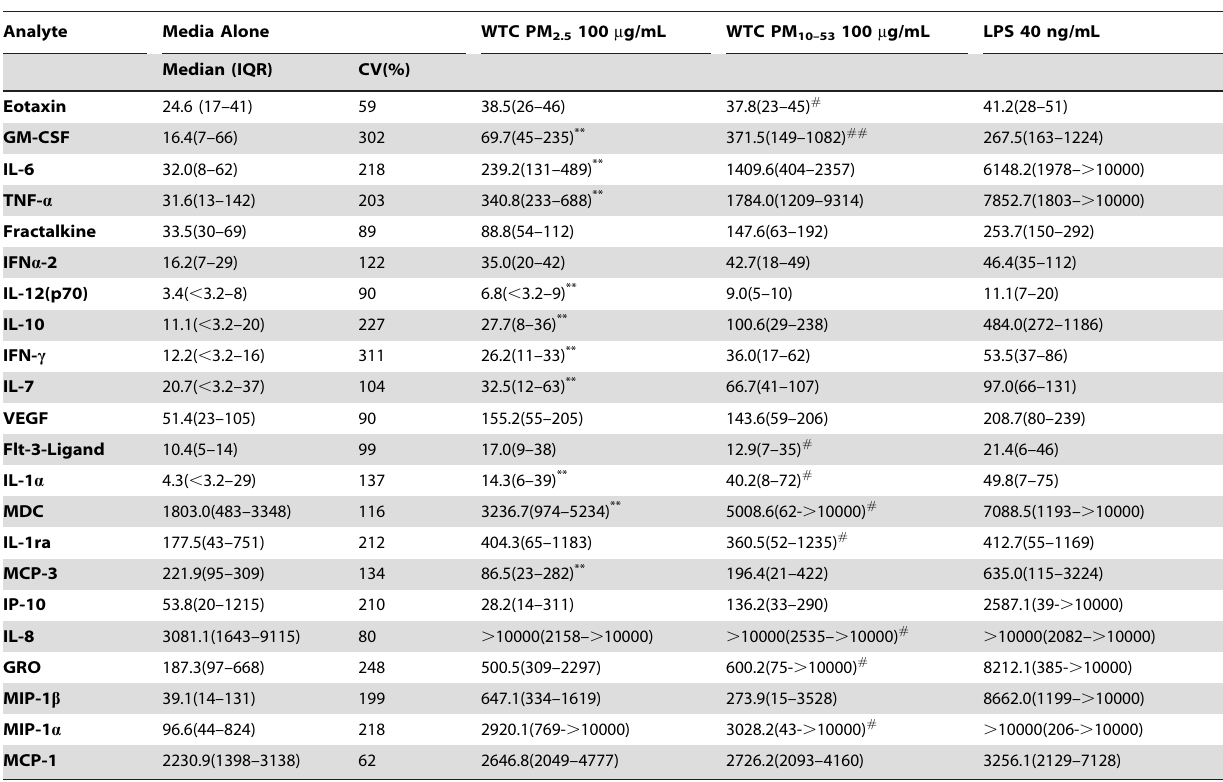
Table 2. In Vitro Expression of Chemokines and Cytokines by Alveolar Macrophages*.